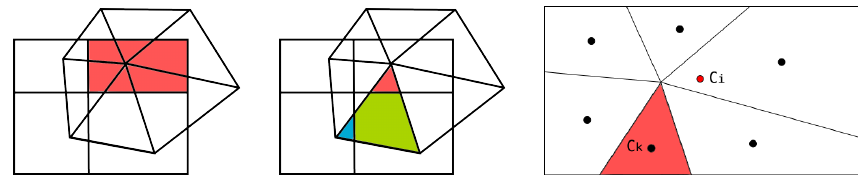
Figure 1. Common refinement of the source and target meshes. Here, the source mesh ( S i ) is quadrangular and the target mesh (T j ) is triangular. The integral over quadrangle S i (red, left panel) must be split among supermesh cells U k as per Eq. (2); supermesh cell areas A k (colored, center panel) serve as interpolation weights. To this end, linear reconstruction is done on each quadrangle. The quadrature points are the supermesh centroids C k (right